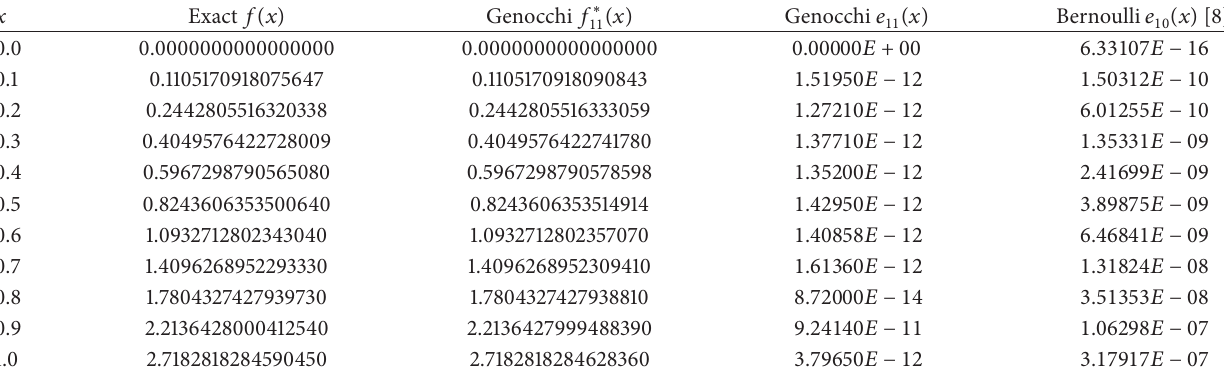
Table 3: Comparison of absolute errors for Example 2 using 𝑁 = 11 orders of Genocchi polynomials and Bernoulli method 𝑁 = 10 [8].